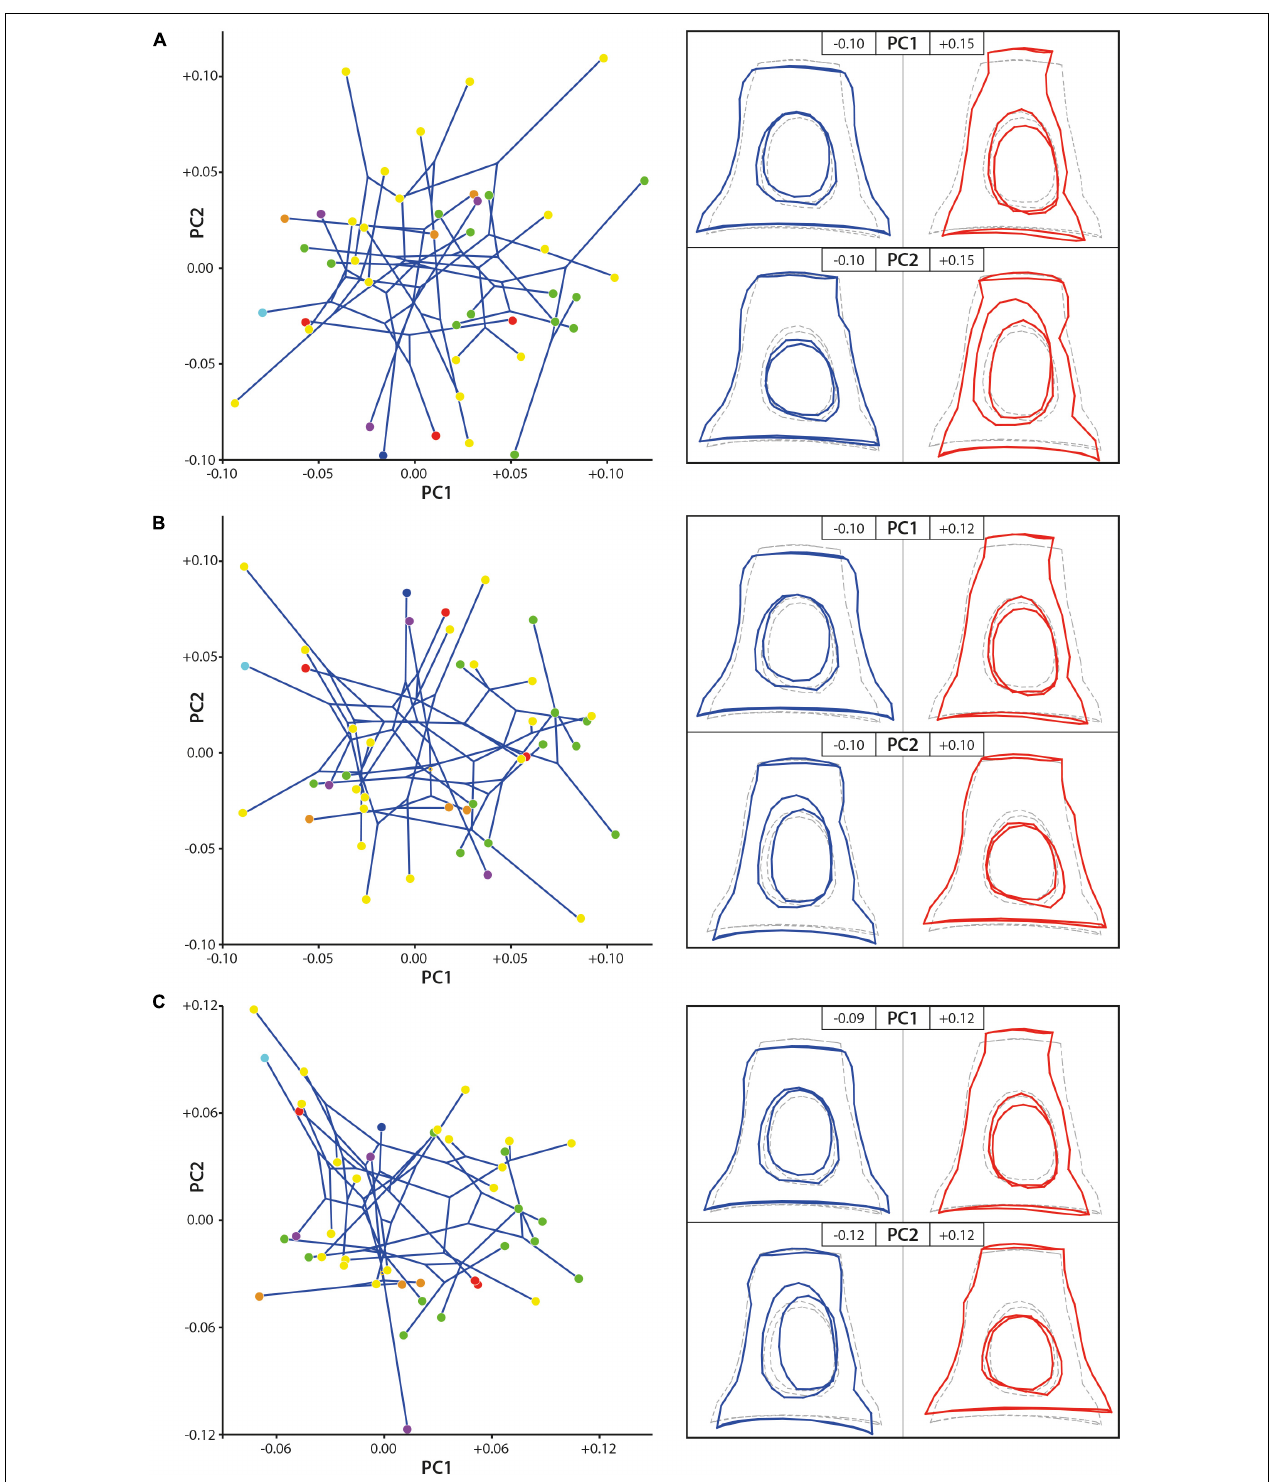
FIGURE 4 | Geometric morphometric PCA results. (A) stapes based on the original 3D landmarks coordinates (dataset 1; PC1 = 13.75%, PC2 = 9.14%), (B) dataset without allometrical signal not pooled by family (dataset 2; PC1 = 13.87%, PC2 = 9.21%), and (C) dataset without allometrical signal pooled by family (dataset 3; PC1 = 13.86%, PC2 = 10.20%). The morphological modifications along the axes (PC) are materialized by the hypothetical stapes shape associated to extreme values. Stem Pecora violet; Antilocapridae red; Bovidae, yellow; Cervidae, green; Tragulidae, orange; Giraffidae, and light blue; Moschidae, dark blue. Statistical results are available in Supplementary Data S3